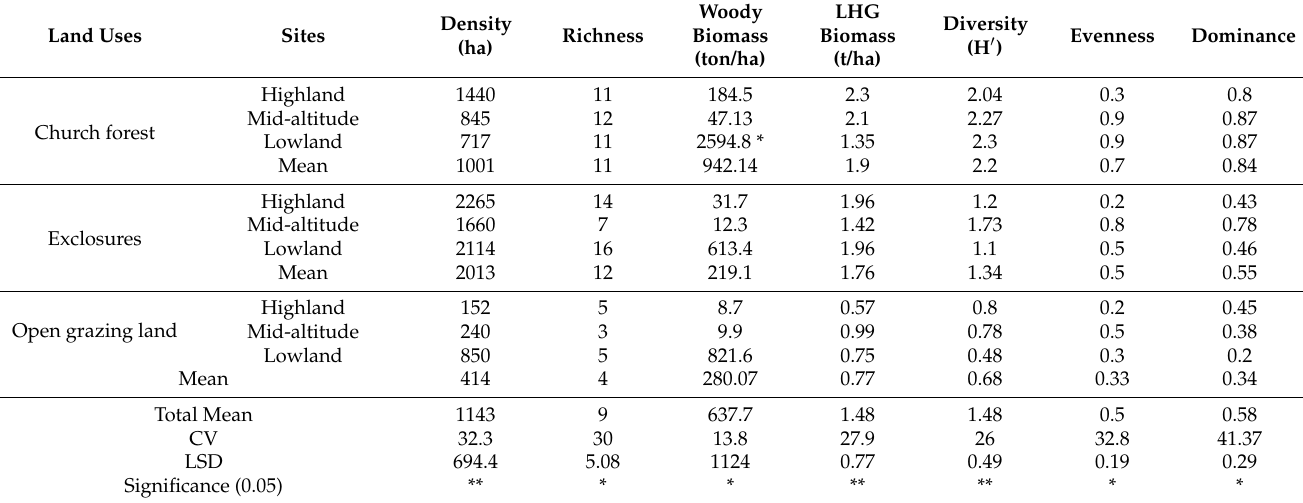
Table A1. Vegetation compotation.